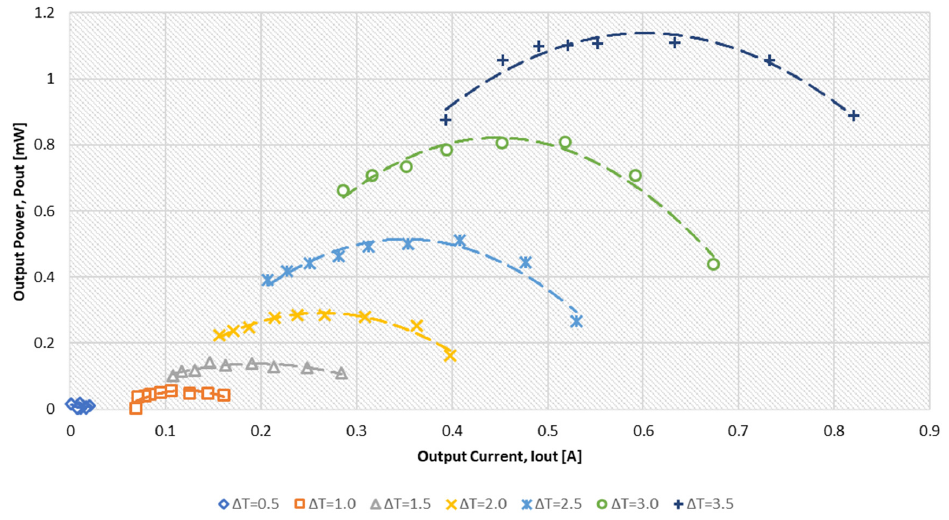
Figure 5. Thermal EHC Output Voltage–Output Current curve at 2.3 V.